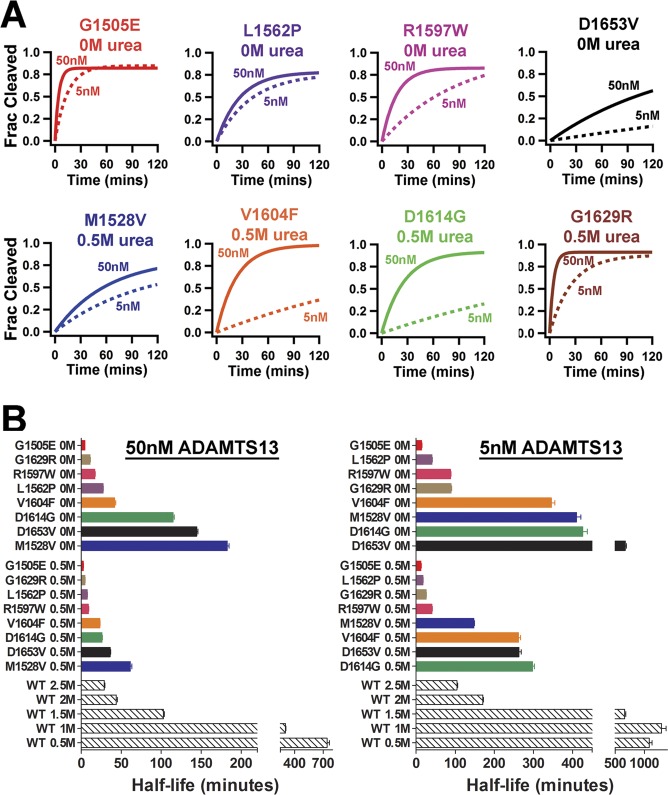
Type 2A VWD variants enhance the rate of ADAMTS13 proteolysis.VWF A2 FRET variants (50nM) and 50nM ADAMTS13 or 5nM ADAMTS13 were separately pre-incubated in 1.25mM CaCl2 ± 0.5M urea for at 37°C for 45mins before being combined to initiate proteolysis. Emission scans were taken at Ex505 every 0.5mins for 120mins, after 2mins ADAMTS13 was added. FRETobs data was converted to Fraction Cleaved (Frac Cleaved). (A) Selected exponential rise fits are shown for type 2A VWD variants with either 0M (upper panel) or 0.5M urea (lower panel) and 50nM (solid lines) and 5nM (dashed lines) ADAMTS13. (B) Half-lives were calculated and are displayed for type 2A VWD variants (grouped by 0M and 0.5M urea in ascending order, various coloured bars) and WT (0.5M, 1M, 1.5M, 2M and 2.5M urea, black diagonal lined bars) in ascending order.